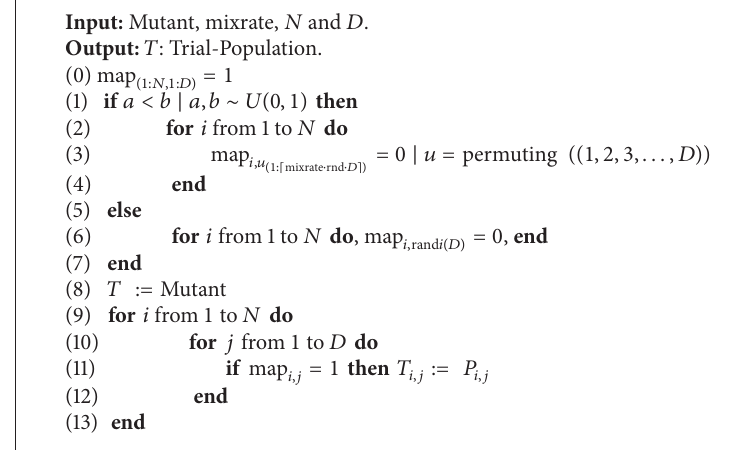
Algorithm 1: Crossover strategy of BSA.